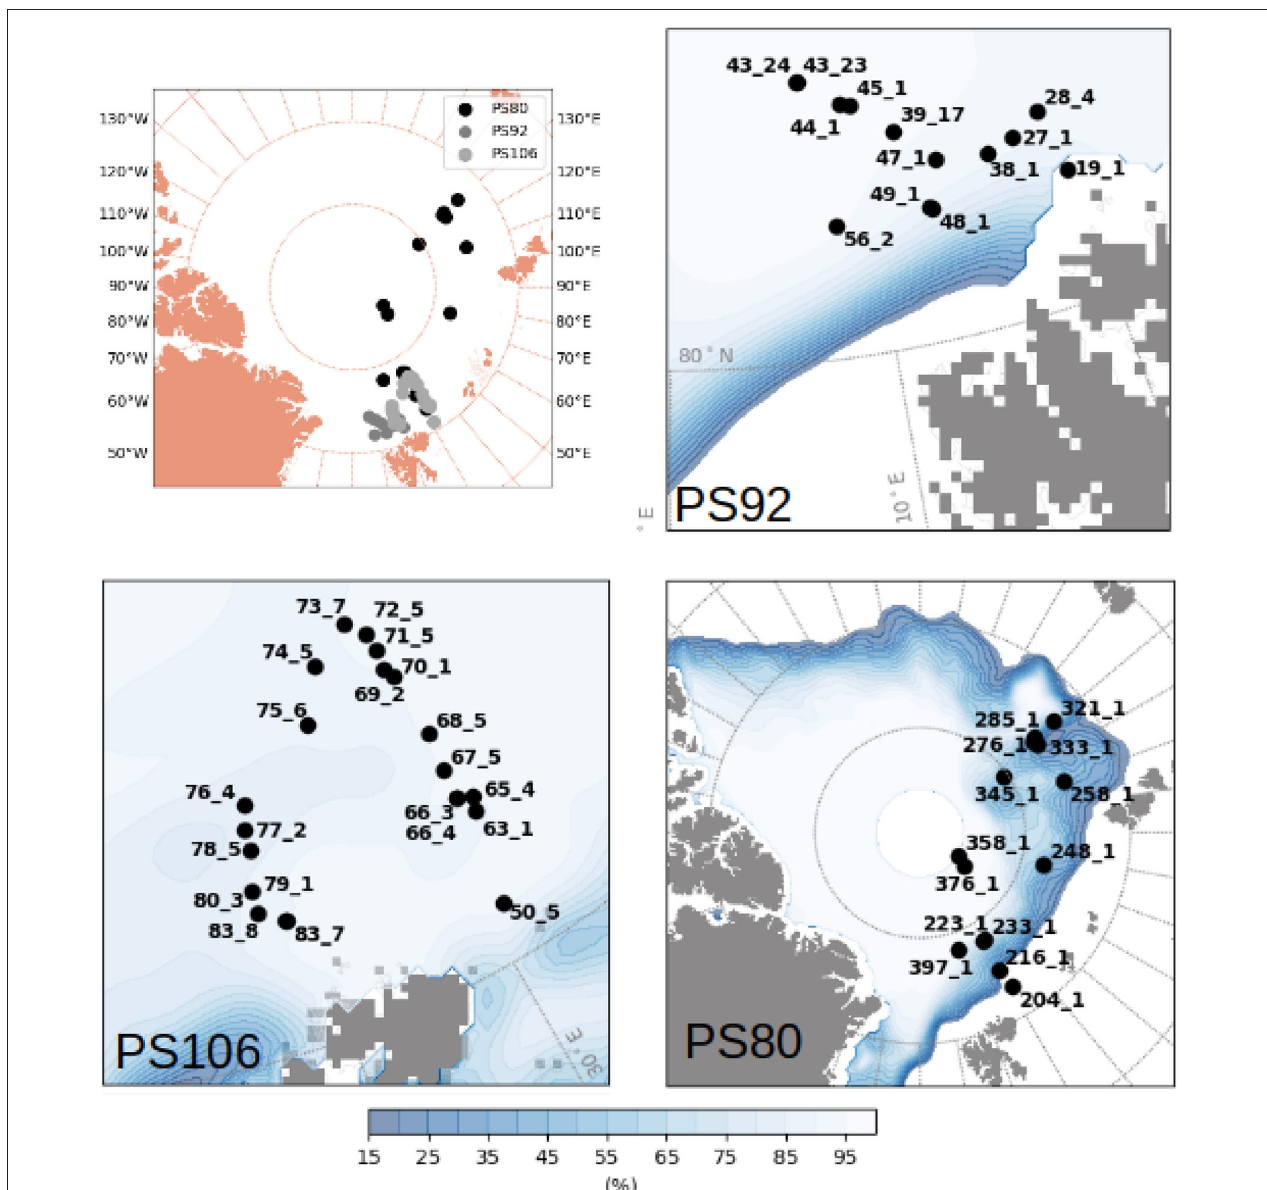
FIGURE 1 | Map of the Arctic with the stations carried out during PS80 (summer-autumn 2012), PS92 (early spring 2015) and PS106 (late spring 2017). Ice concentration averaged over the period of sampling of each expedition was taken from OSISAF (EUMETSAT, 2011).